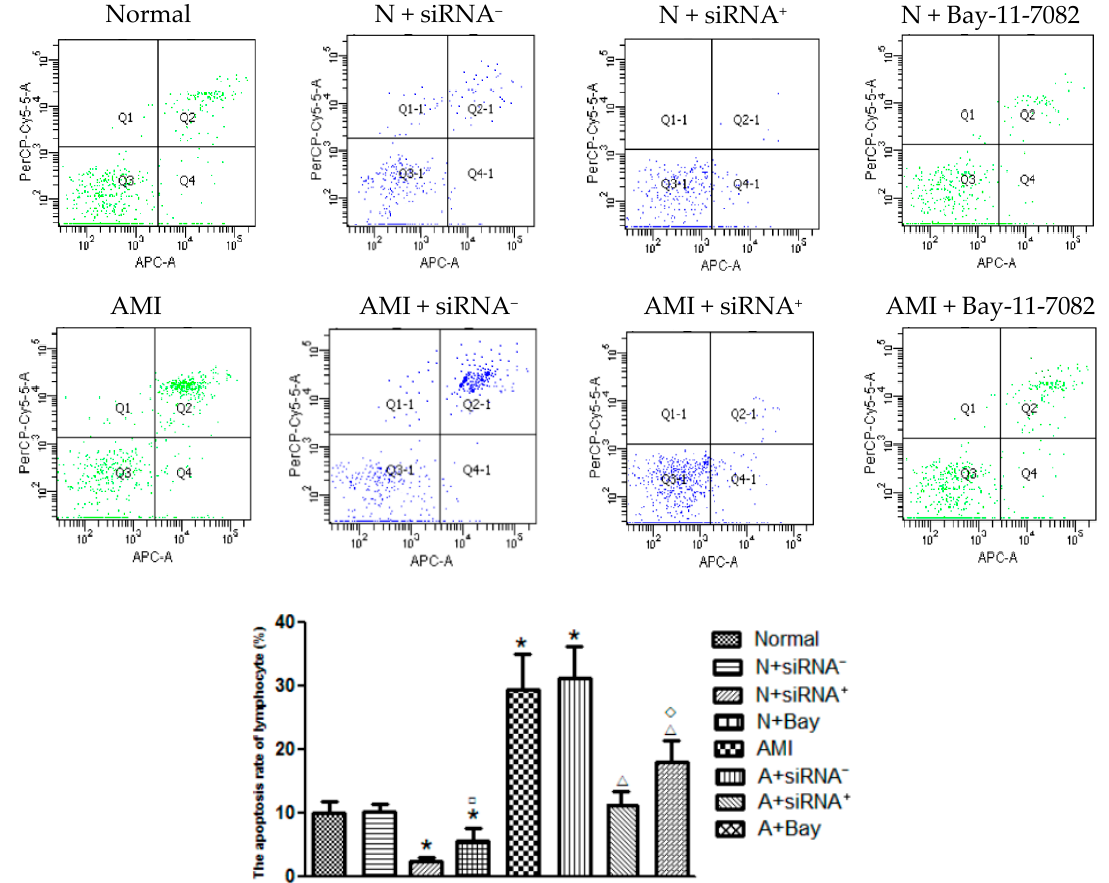
Figure 6. T cells apoptosis rate changed by CaSR siRNA transfection and Bay11-7082 ( n = 20). The cell apoptosis rate was measured after T lymphocytes were transfected by CaSR siRNA plasmids for 24 h or were cultured by NF- κ B pathway blocker Bay-11-7082 (10 mM) for 15 min. The apoptosis rate of all these T cells was quantified by densitometry. * p < 0.05 vs. Normal; □ p < 0.05 vs. Normal + siRNA + ; Δ p < 0.05 vs. AMI; ◊ p < 0.05 vs. AMI + siRNA + .